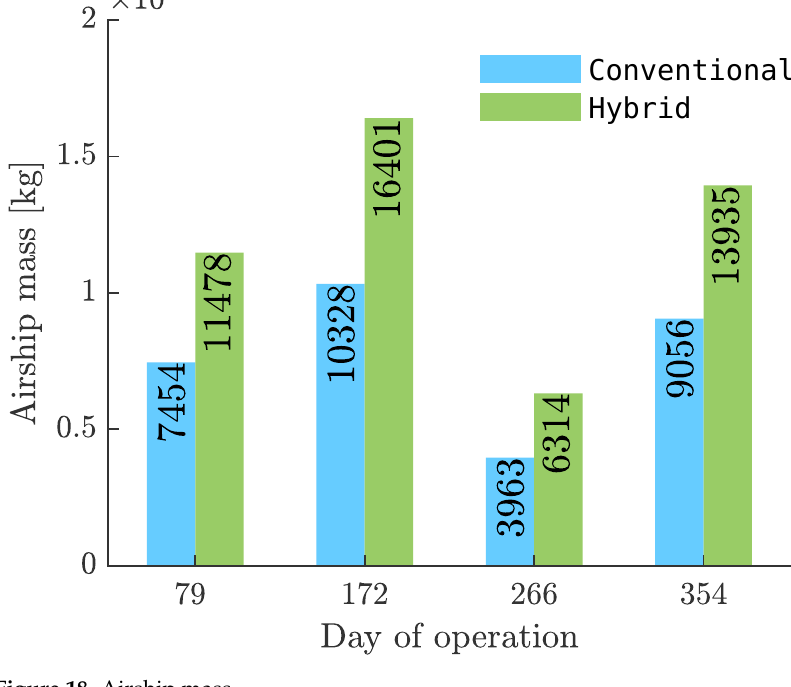
Figure 18. Airship